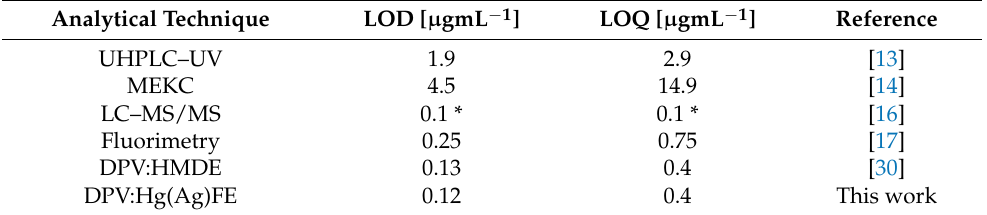
Table 1. The comparison of the sensitivity of selected analytical techniques for rifampicin.